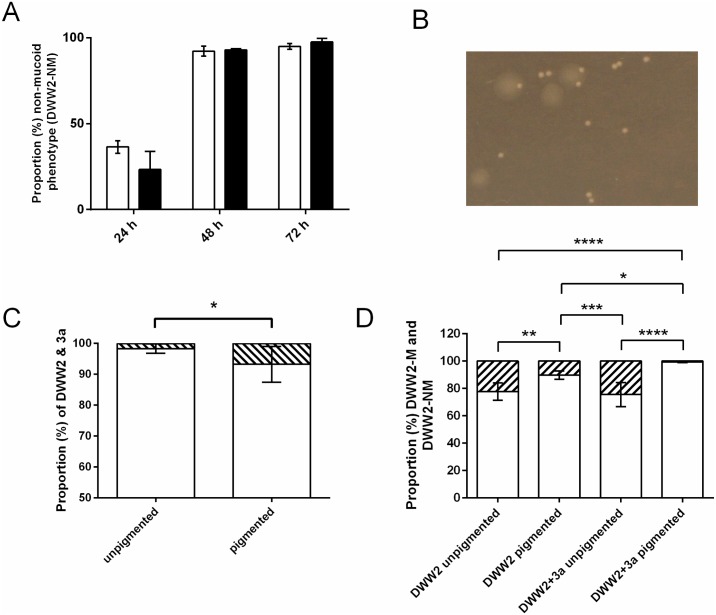
A non-mucoid colony phenotype of P. aeruginosa strain DWW2 (DWW2-NM) and higher numbers of S. anginosus strain 3a are associated with pigment (pyocyanin) production in co-culture biofilms.(A) The proportion (percentage) of the non-mucoid P. aeruginosa colony phenotype (DWW2-NM) increases over 72hrs in 10% CO2 in mono-culture (white bars) and in co-culture (black bars). Data values are mean and standard deviation of 4 whole independent biofilms in each case. (B) Larger mucoid (DWW2-M) and smaller, non-mucoid (DWW2-NM) colony phenotypes (derived from strain DWW2 48 h biofilms) cultured on PIA. (C) The proportions (percentages) of DWW2 (white bar) and 3a (black bar) in the sampled green pigmented and non-pigmented areas of co-culture biofilms at 48 h showing an increased proportion of 3a associated with pigment production. Data values are mean CFU per sample ± SD of 8 samples. Statistical analysis comparing bacterial counts obtained for strain 3a and DWW2 in pigmented and non-pigmented areas were by two-tailed Mann-Whitney U test: * = p<0.05. (D) The presence of S. anginosus 3a stimulates an increased conversion of DWW2 to the non-mucoid phenotype (DWW2-NM). The proportion (percentage) of mucoid (DWW2-M) (shaded bars) and non-mucoid (DWW2-NM) (white bars) colony phenotypes arising in non-pigmented and pigmented areas of mono- (DWW2) and co-culture (DWW2+3a) biofilms after 48 h incubation in 10% CO2. Data values are shown as mean and SD of 7 samples from pigmented and non-pigmented areas. Statistical analysis was by one-way ANOVA for parametric data with Tukey multiple comparison test (* = p<0.05; ** = p<0.01; *** = p<0.001; **** = p<0.0001).